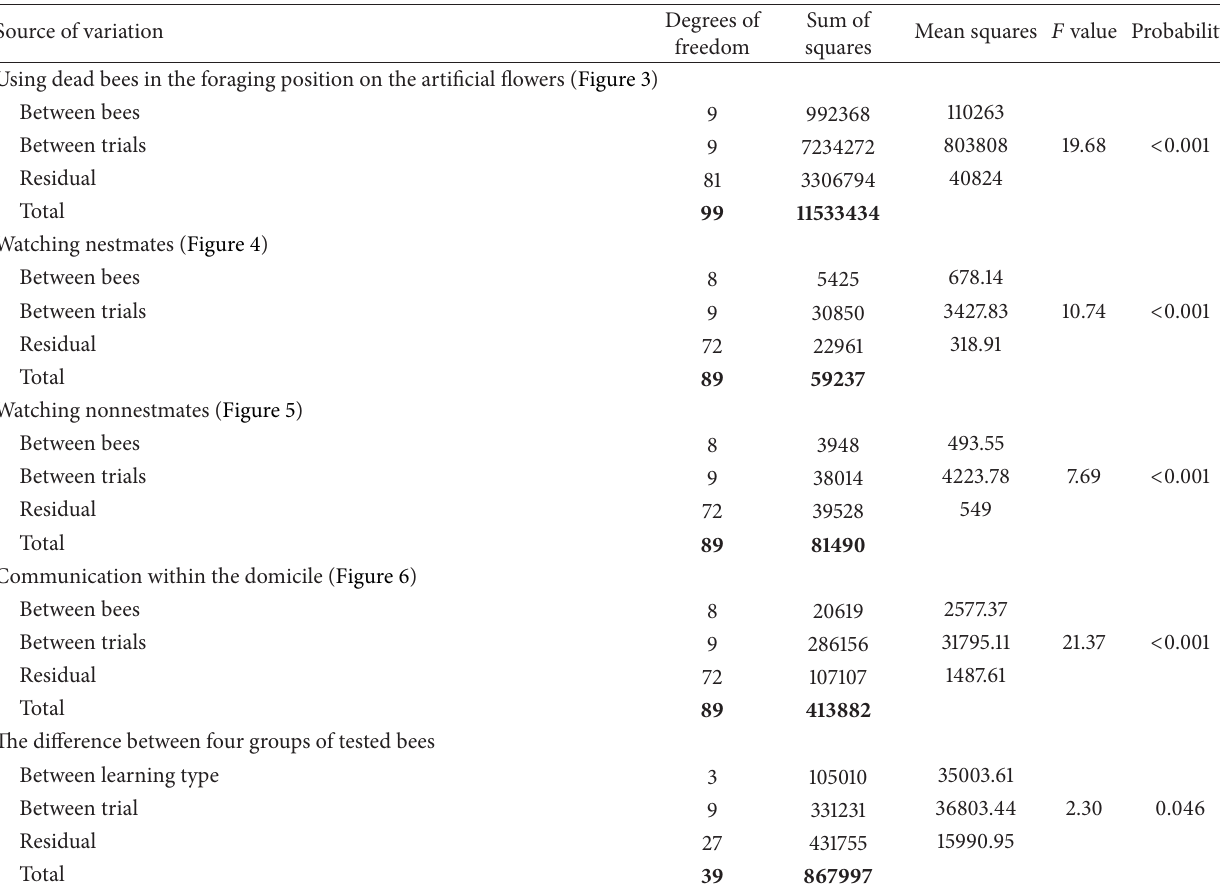
Table 1: Statistical values from repeated one-way Analysis of Variance of the findings from experiments in which dead bees were used as models to aid in the learning process for foraging by living bees, in which living bees were able to watch other living bees (nestmates and nonnestmates) forage to aid in the learning process and in which living bees which had no opportunity to observe models or other living bees foraging learned to forage by within-colony communication. Degrees of Source of variation Mean squares 𝐹 value